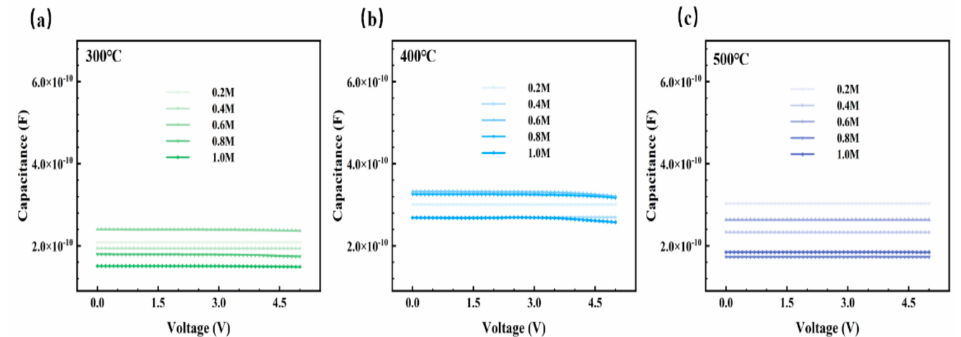
Figure 13. ZYAMO thin film capacitance after different temperature annealing: ( a ) 300 ◦ C, ( b ) 400 ◦ C, and ( c ) 500 ◦ C.